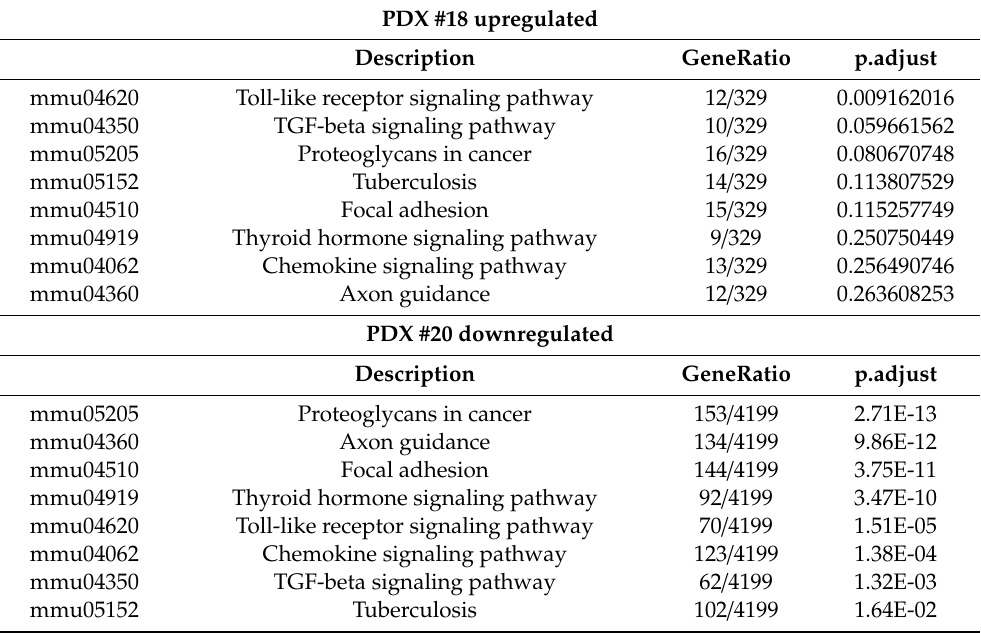
Table 1. KEGG pathways